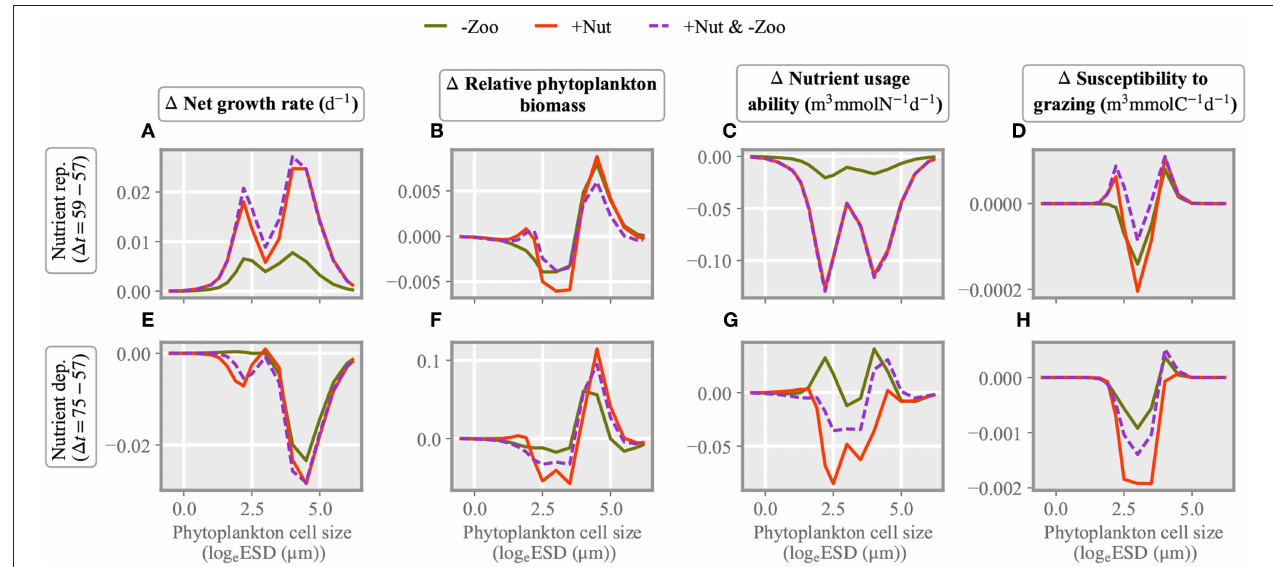
FIGURE 6 | Changes in size dependent characteristics from the state before stressor application: in the contribution of each size class to total net growth rate (A,E) , in the phytoplankton density distribution (B,F) , and in interaction traits, the relative nutrient usage ability (C,G) and susceptibility to copepod grazing (D,H) . The difference is taken either 2 (A–D) or 18 days (E,F) after stressor